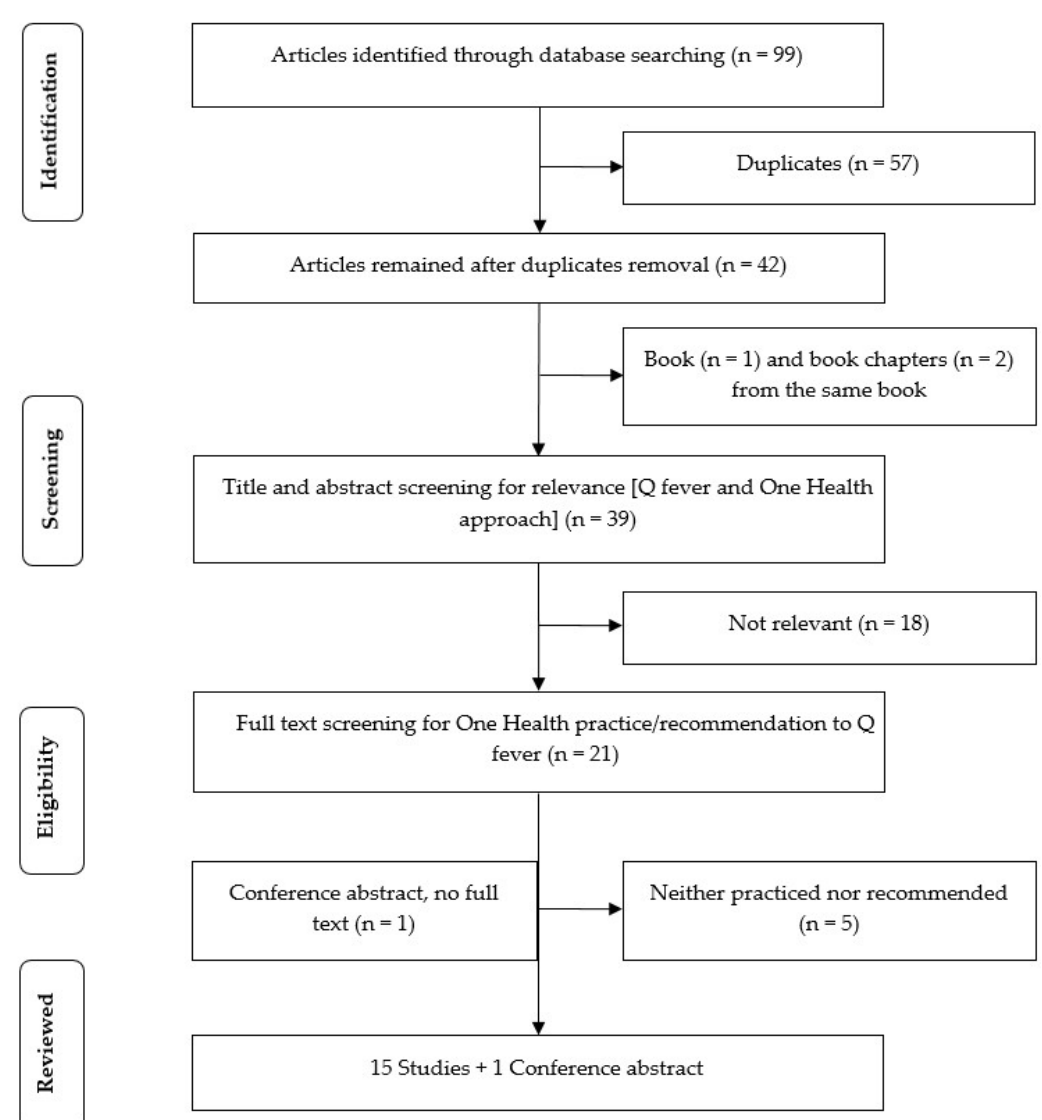
Figure 1. PRISMA flow diagram of the study selection process.